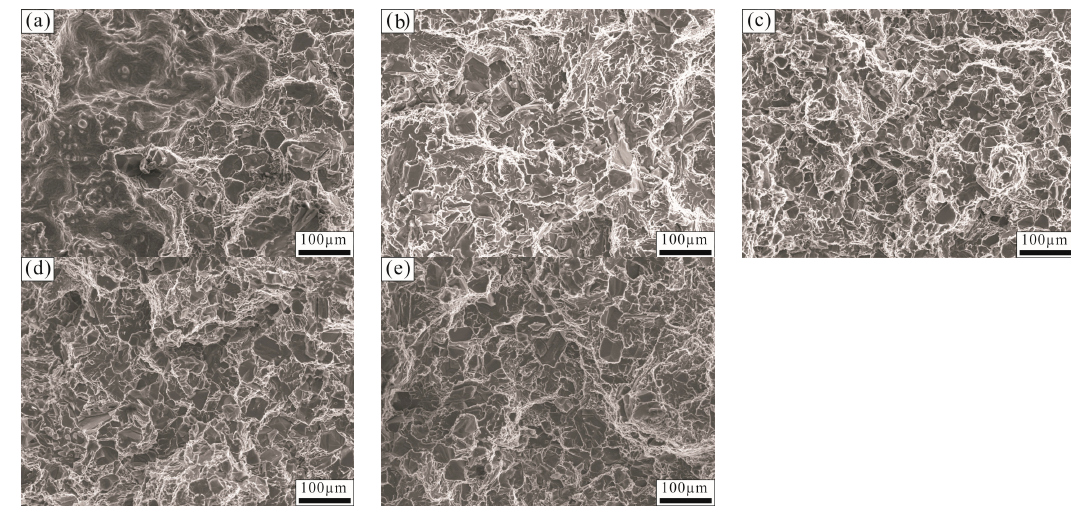
Figure 7. Fracture morphologies of the tensile samples of the Al–18Si alloy ( a ) melted at 850 °C and unmodified; ( b ) modified at 850 °C with 0.1 wt % Al–3B; ( c ) modified at 850 °C with 0.2 wt % Al–3B; ( d ) modified at 850 °C with 0.4 wt % Al–3B; and ( e ) modified at 850 °C with 0.6 wt % Al–3B.